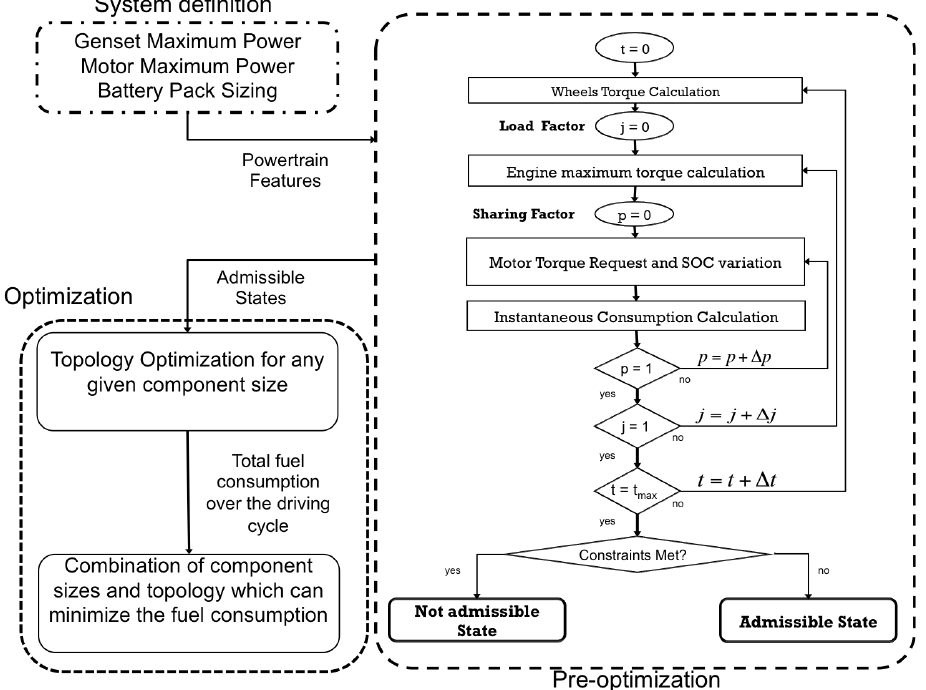
Figure 1. Algorithm